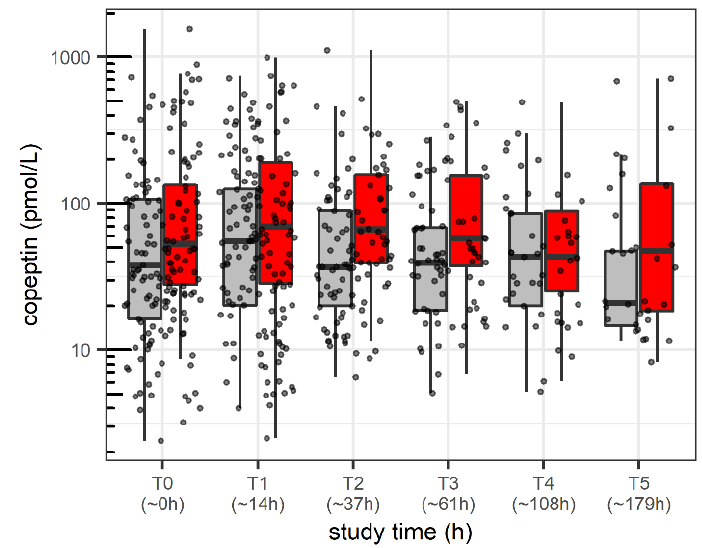
Figure 2. Blood copeptin levels over the study period stratified by presence of arterial hypotension, red boxes; arterial normotension, gray boxes. Boxes represent the interquartile range (IQR). Solid lines are the median, 25th and 75th quantile, and whiskers equal to 25th quantile − 1.5 IQR and 75th quantile +1.5 IQR. Corresponding time points: T0 = study start; T1 = 14 h (median, interquartile